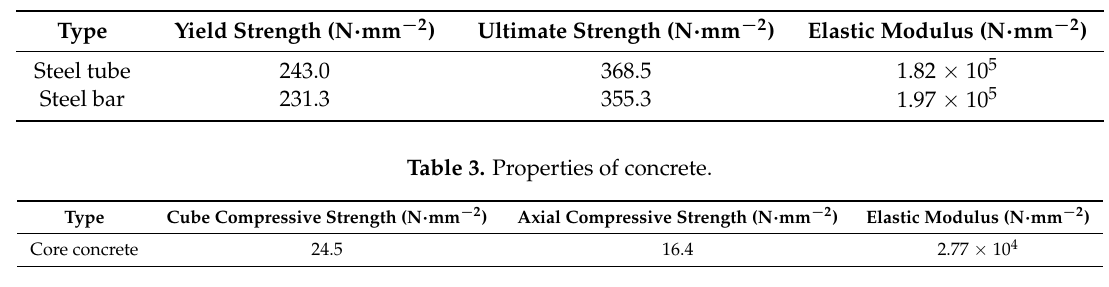
Table 2. Properties of steel materials.